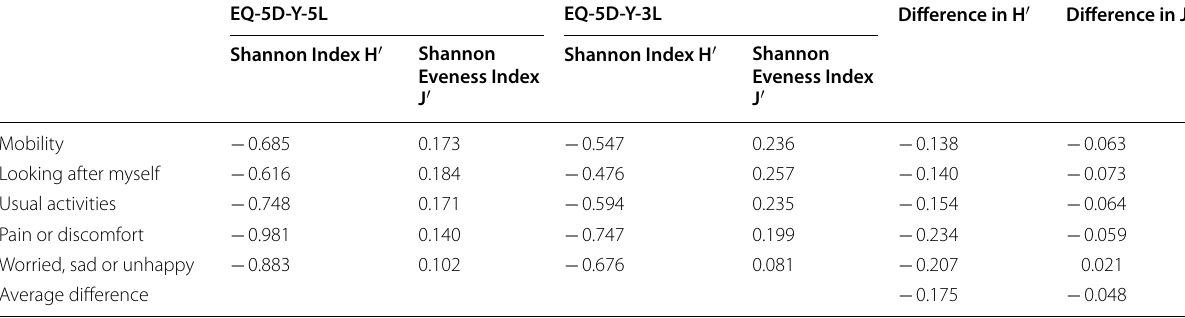
Table 4 Shannon Index (H ′ ) and Shannon Evenness Index (J ′ ) for the EQ-5D-Y-3L and EQ-5D-Y-5L